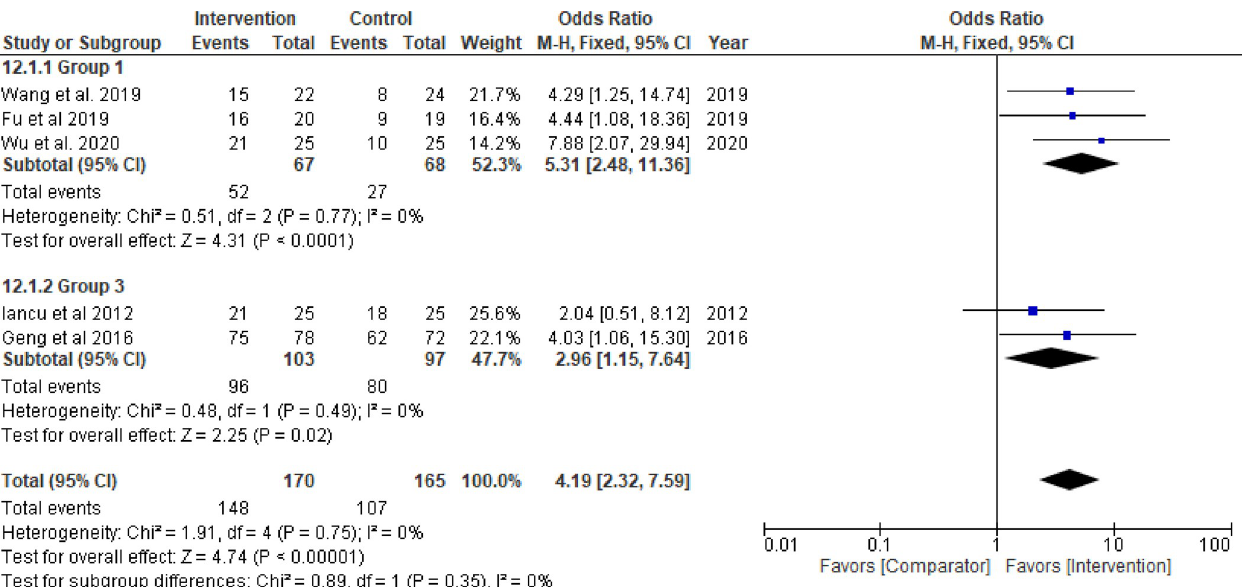
Fig 5. TIMI myocardial perfusion grade 3. Group 1: Thrombolytic agent; Group 3: GPI plus aspiration thrombectomy (No pooled data for Group 2).